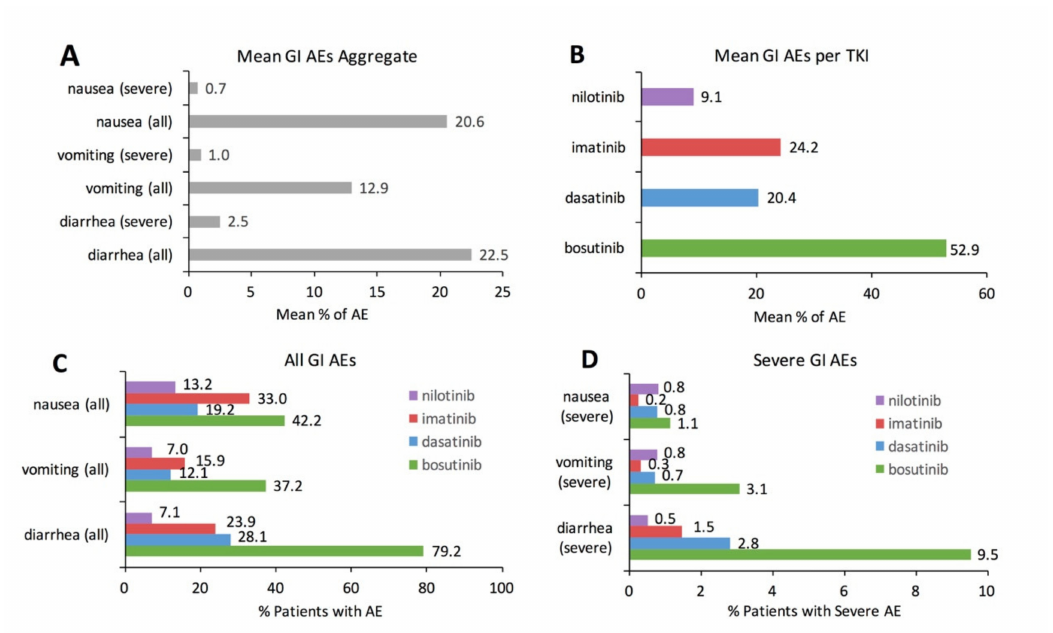
Figure 1. Descriptive statistics for the incidence of gastrointestinal adverse events (GI AEs) with tyrosine kinase inhibitor (TKI) therapy in chronic myeloid leukemia (CML) patients. ( A ). Mean incidence of nausea, vomiting, diarrhea aggregated across all included TKIs (bosutinib + dasatinib + imatinib + nilotinib). ( B ). Mean incidence of GI AEs for each separately included TKI (bosutinib, dasatinib, imatinib, nilotinib). ( C ). Actual or raw incidence of specific GI AEs (nausea, vomiting, and diarrhea) for each separately included TKI. ( D ). Actual or raw incidence of specific severe GI AEs (nausea, vomiting, diarrhea) for each separately included TKI. “Severe” is defined as a grade 3 or grade 4 AE based on the MedDRA SOC categorization as listed in the Common Terminology Criteria for Adverse